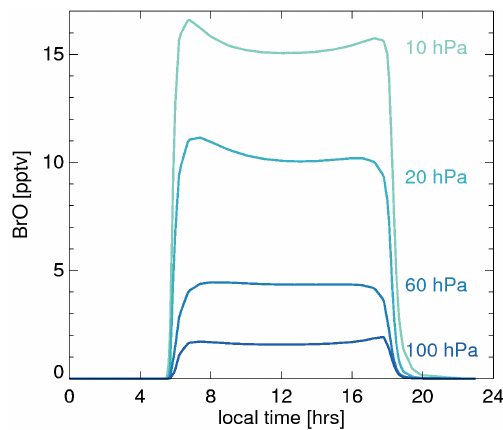
Fig. 8. Same as Fig. 7, except that the data correspond to July in- stead of January 2005.